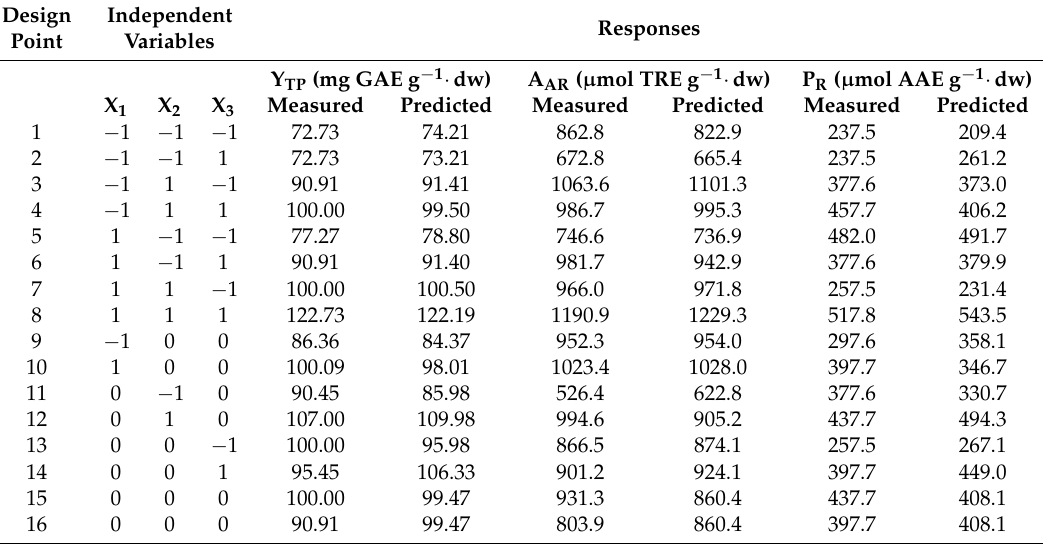
Table 3. Measured and predicted Y TP , A AR and P R values determined for the individual design